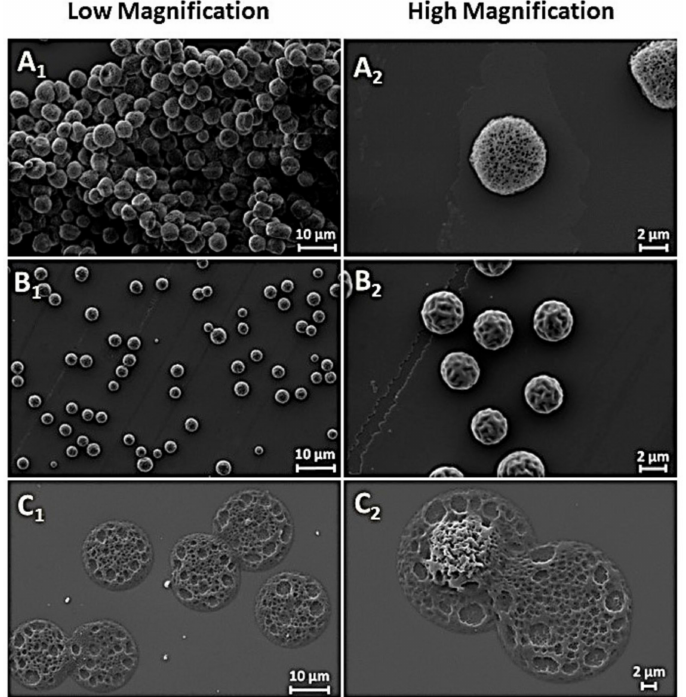
Figure 6. SEM images of ( A ) the 3 wt.% PLA–DCM group sample. ( B ) SEM images and of the 3 wt.% PLA ethanol–chloroform group sample. ( C ) SEM images of the 2 wt.% PLA–chloroform group sample